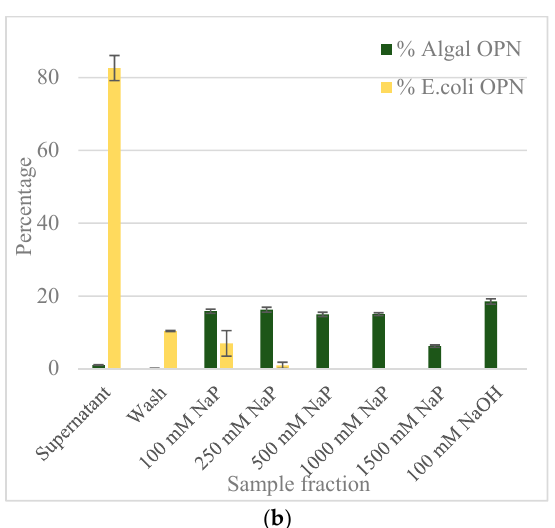
Figure 4. OPN distribution in fractions obtained with ceramic hydroxyapatite (CHT) resin ( a ) with no salt; ( b ) with 250 mM NaCl. Step elutions were performed with sodium phosphate (NaP) buffer, pH 6.8. Data (% OPN) were generated by ImageJ analysis of anti-FLAG western blots and normalized by the amount in the lysate. Error bars indicate standard deviation of triplicate ImageJ measurements. The adsorbed E. coli and C. reinhardtii OPN, respectively, were eluted using increasing strength